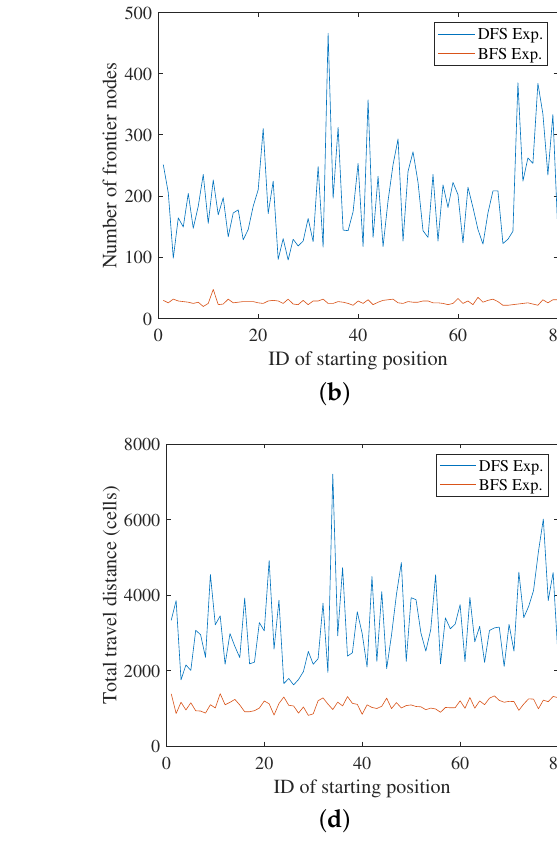
Figure 7. Simulation results. Maximum range of the LRF is 8 m: ( a ) Number of exploration steps until completion of exploration. ( b ) Total number of registered frontier nodes in the frontier-graph. ( c ) Number of active nodes. ( d ) Total traveling